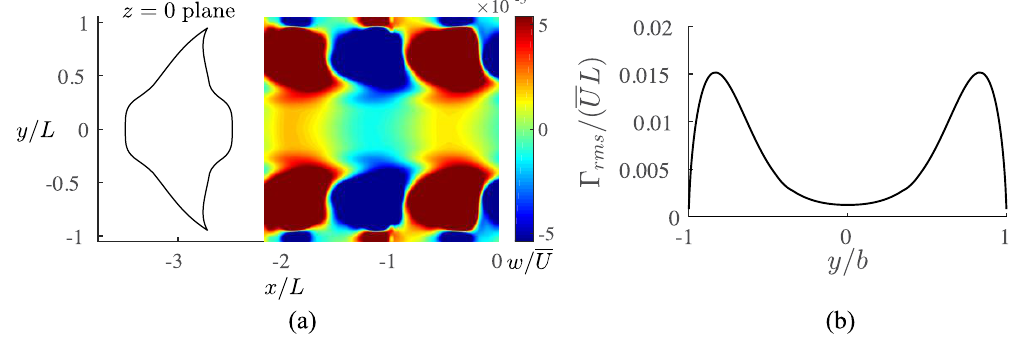
Figure 15. ( a ) w component of velocity in wake of the ray on the z = 0 plane; ( b ) Root-mean-squared circulation distribution along the span of the ray.